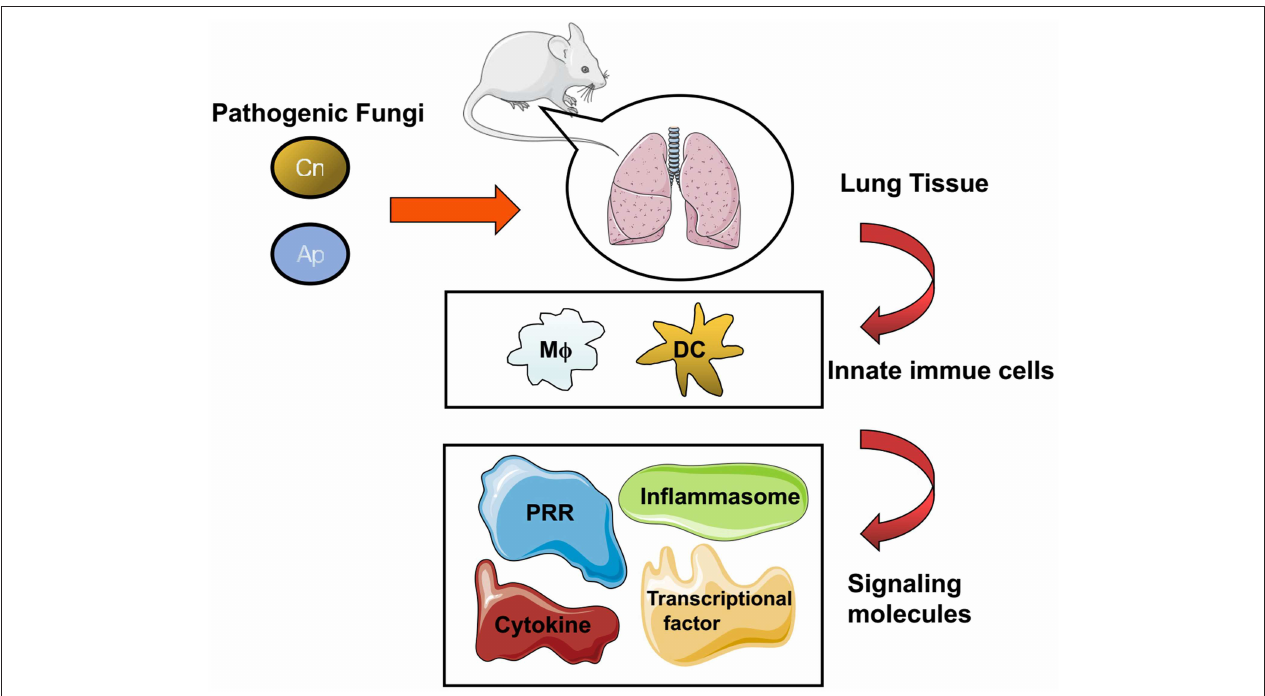
FIGURE 1 | General cellular and molecular components against fungal infection in the lung. The pathogenic fungi including Cryptococcus neoformans (Cn), Aspergillus (Ap), Pneumocystis (Pc), and Endemic fungi (Ef) can cause pulmonary infection in human and in murine models. Fungal pathogens could trigger host immune response upon inhalation, and lung tissue is the major infectious target of these pathogens. Once the infection is initiated, multiple cells either resident in the lung tissue or recruited from blood and lymphoid organs are motivated to clear the invasive fungi. After entering host cells, molecules including receptors, adaptors, or effectors come into play with divergent roles to respond to the fungal